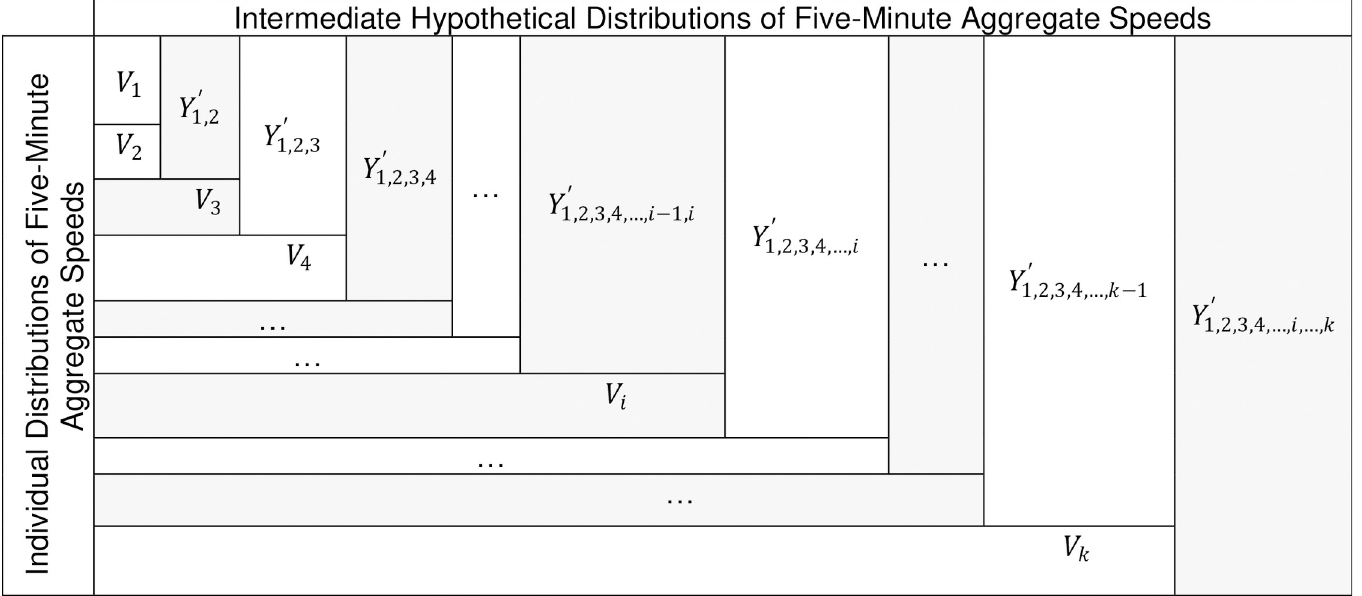
Fig 8. Illustration of the chaining process of k sampling distributions of five-minute aggregate speeds.